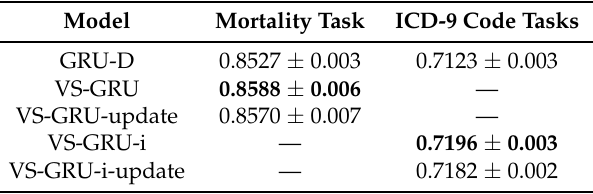
Table 6. Comparison on the missing rate on MIMIC-III.